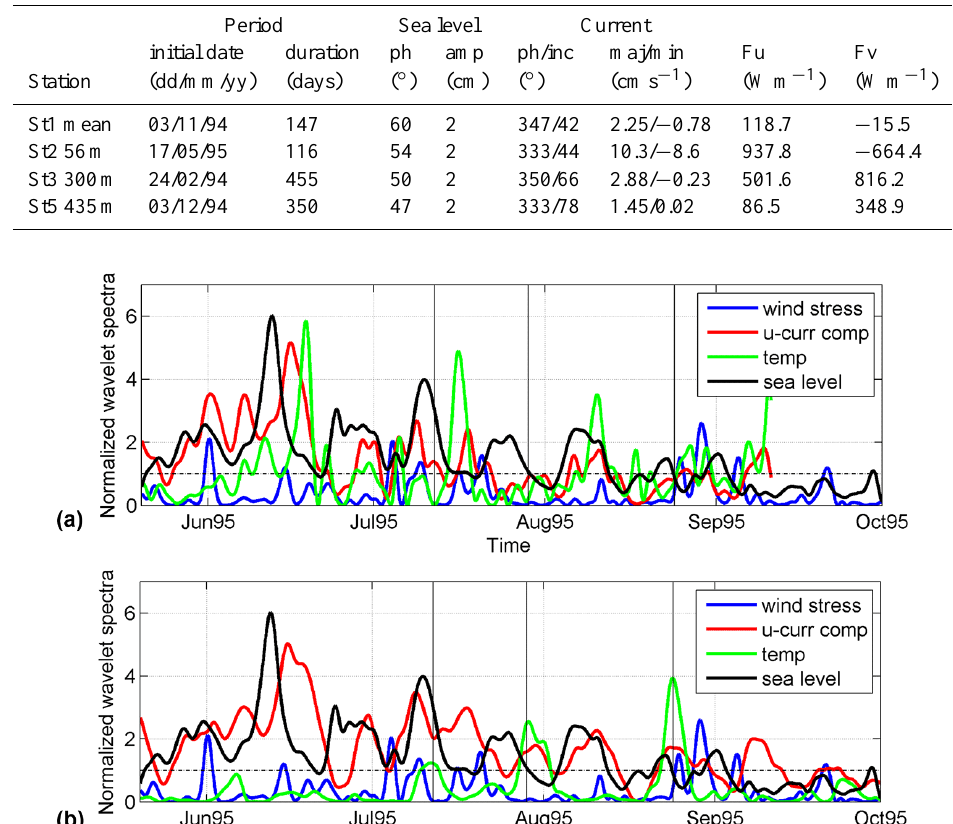
Table 1. Barotropic K1 tidal energy fluxes (Fu-East and Fv-North) and parameters used for their calculation: phase (ph) and amplitude (amp) for the sea level, and phase/inclination (inc) and semi-major/semi-minor axis amplitudes of tidal ellipse for the currents.